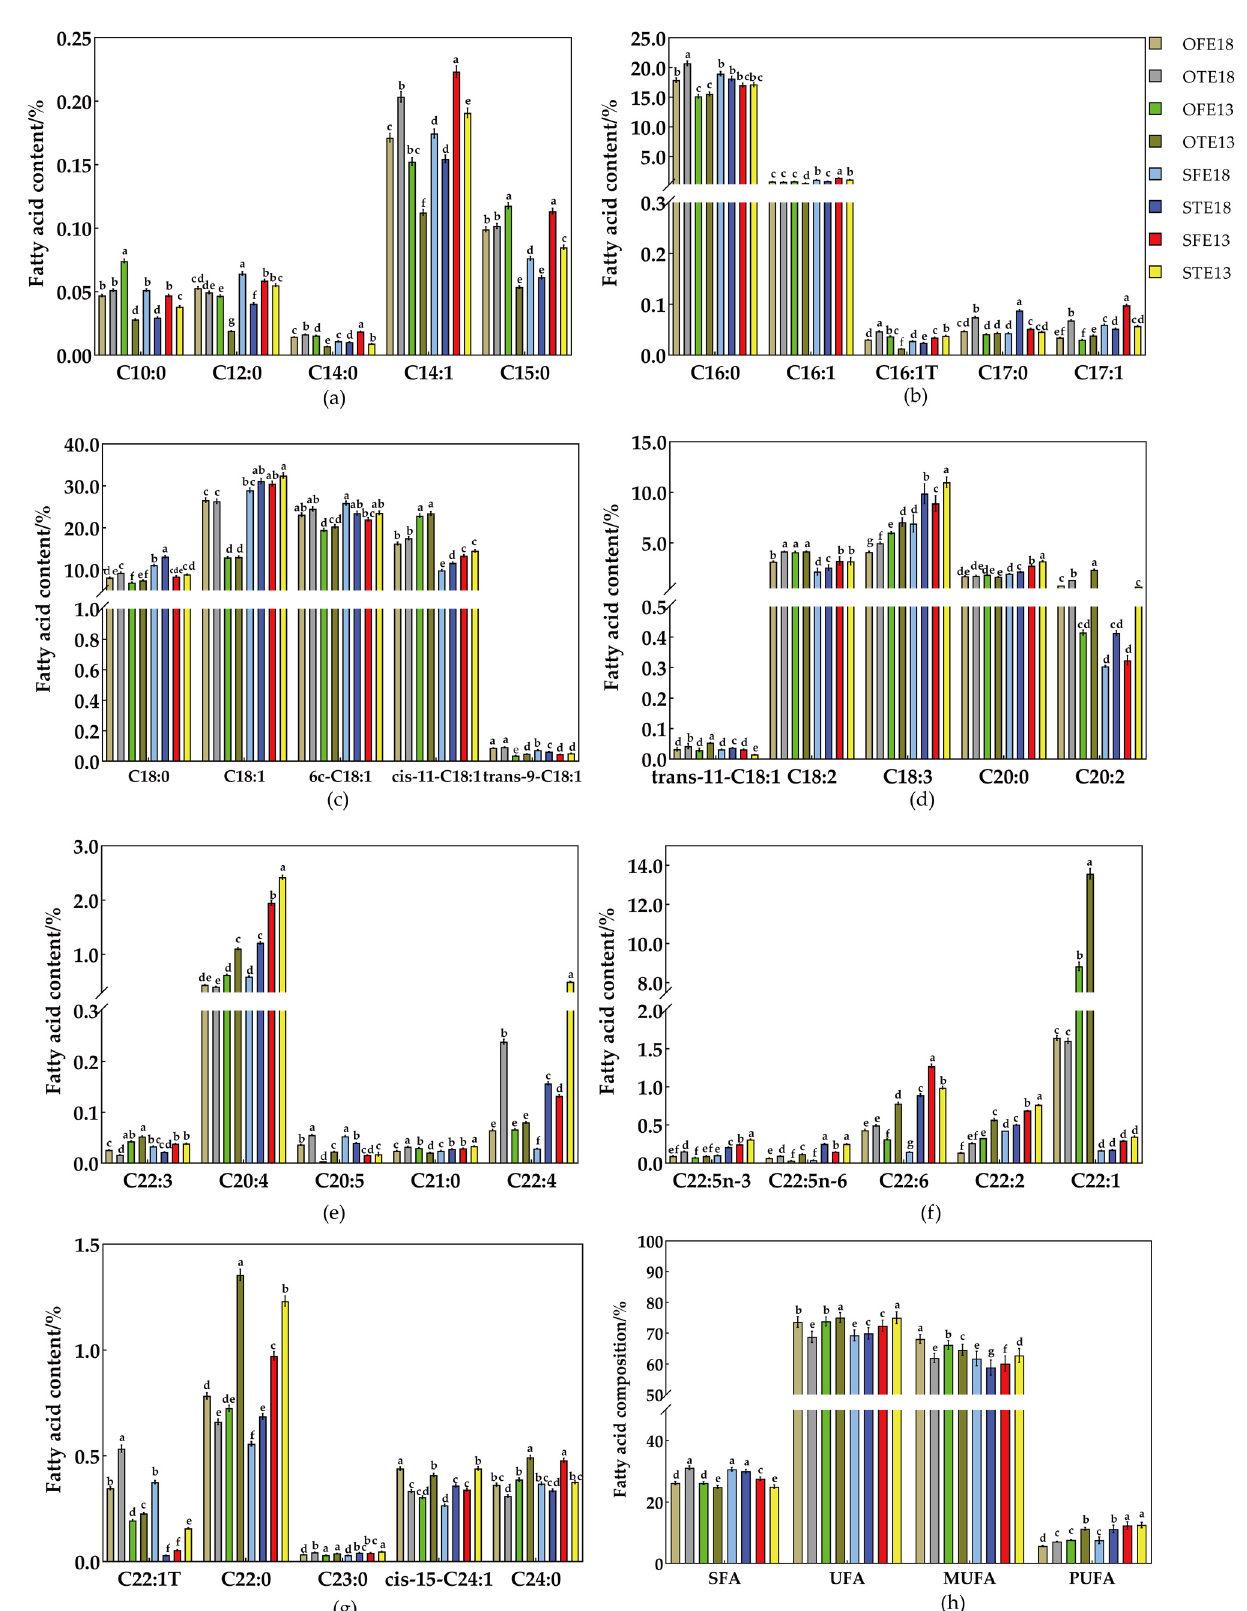
Figure 2. Qualitative and quantitative analyses of medium- and long-chain fatty acids. ( a – g ) Content of 35 medium- and long-chain fatty acids in the WTSL and STSL during different developmental stages. ( h ) SFA, UFA, MUFA, and PUFA content in the WTSL and STSL at different nighttime